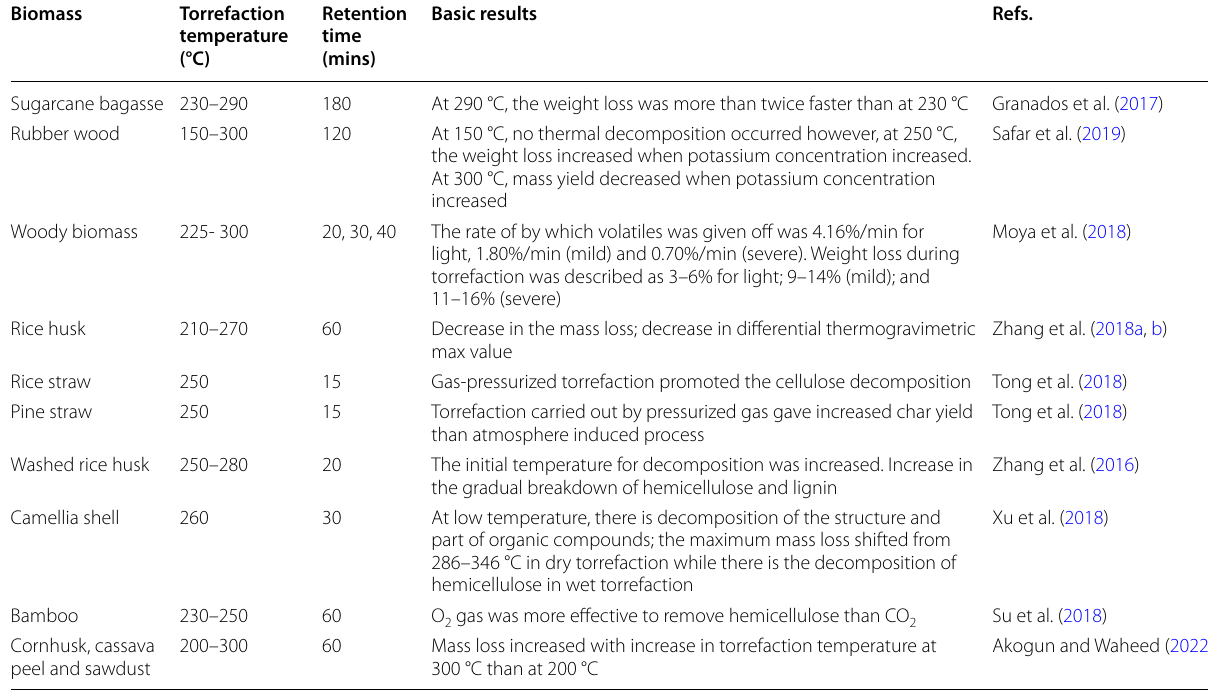
Table 3 Summary of the torrefaction temperature, retention time and results obtained on some selected lignocellulosic biomass